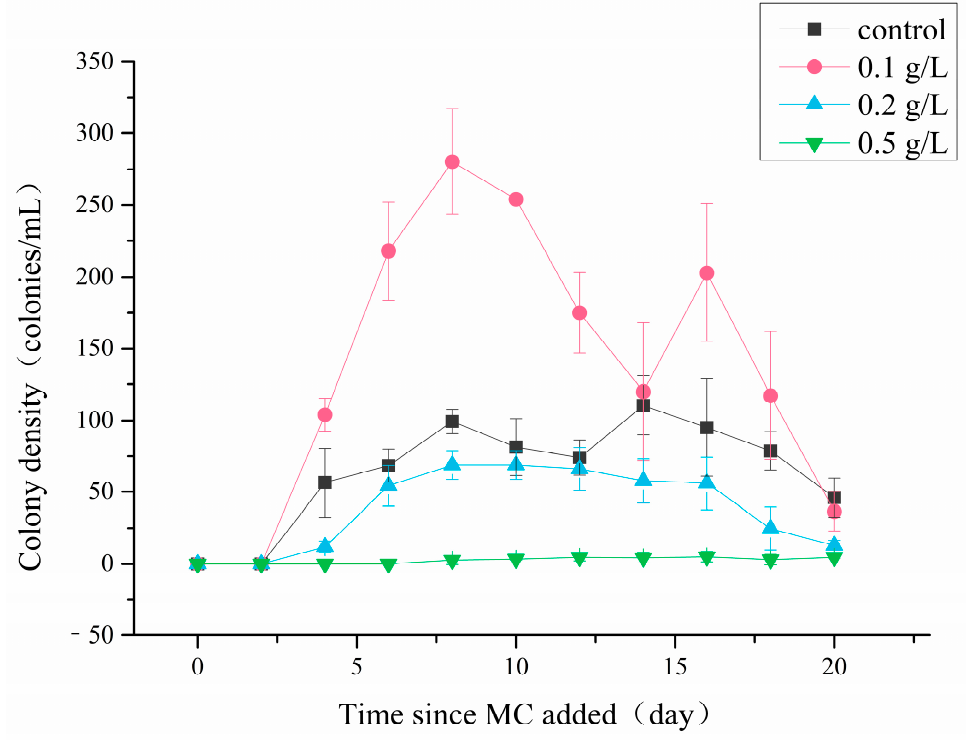
Figure 3. Changes in the density of P. globosa colonies after treatment with different concentrations of